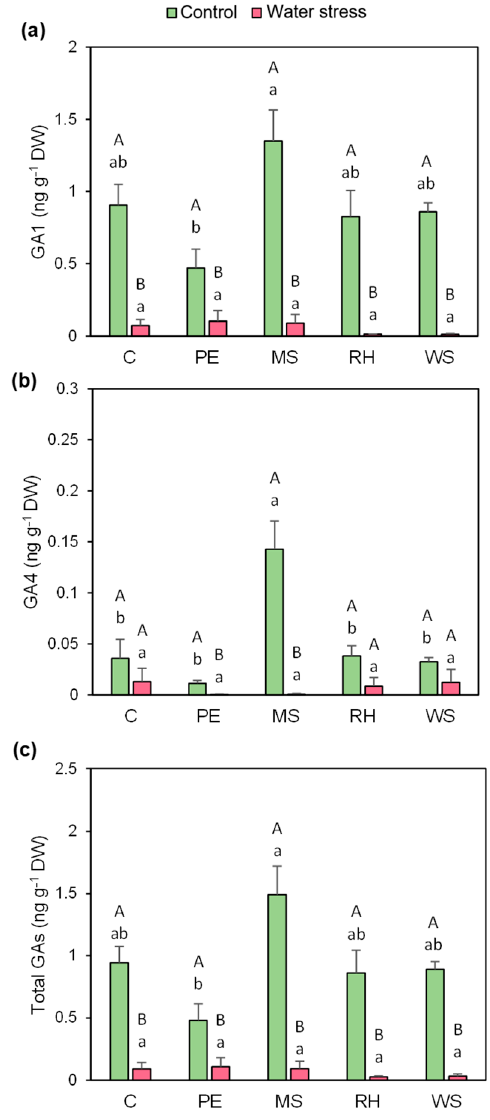
Figure 5. ( a ) Gibberellin A1 (GA1), ( b ) gibberellin A4 (GA4), and ( c ) total gibberellin (GAs) concentra- tions in leaves of escarole plants of the commercial variety “Brillantes” non-mulched or subjected to different mulching treatments and cultivated under control (well-watered) and water stress (70% ETc) conditions. Bars show the means of five plants ± standard error. Different capital letters indicate significant differences due to the water stress treatment while different small letters show significant differences among mulching treatments according to Tukey’s test ( p ≤ 0.05). Abbreviations used: non-covered substrate (C), polyethylene mulch (PE), mushroom substrate-based hydromulch (MS), rice hulls-based hydromulch (RH), and wheat straw-based hydromulch (WS).